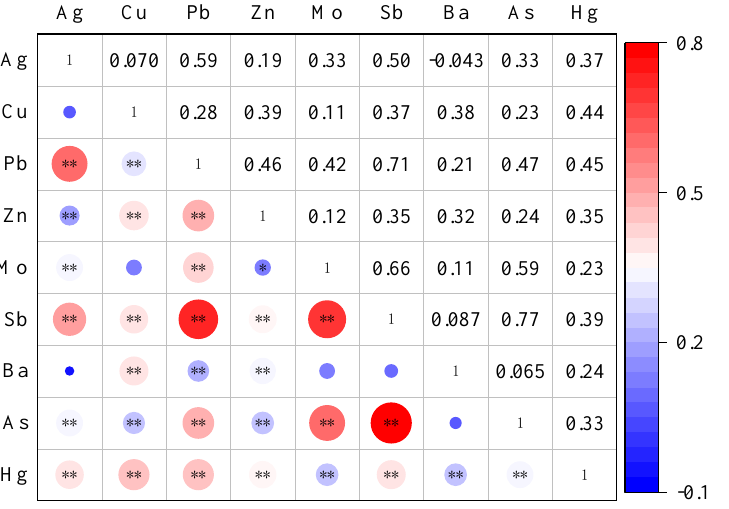
Table 3. Fitting results of measured values and simulated predicted values of soil element content.